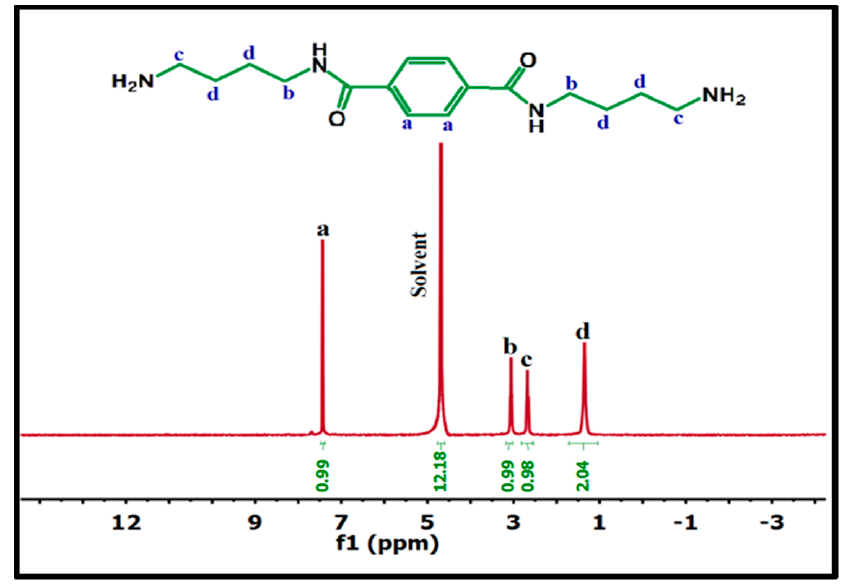
Figure 1. Hydrogen nuclear magnetic resonance ( 1 H NMR) spectra of N 1 , N 4 -bis(4-aminobutyl) terephthalamide (BABT) diamine.